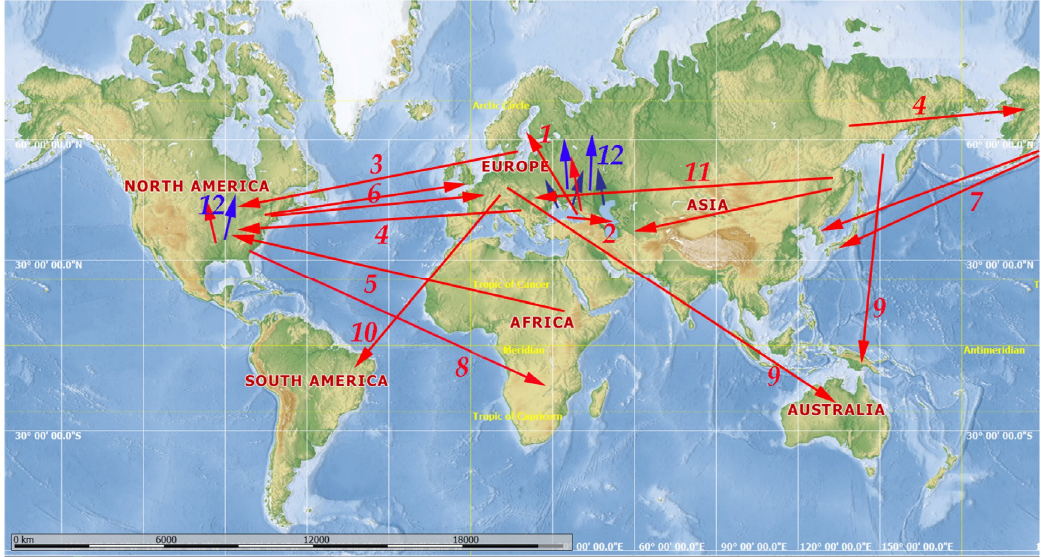
Figure 1. Main pathways of cladoceran long-distance transportation (red arrows) and range expansions (blue arrows) discussed in this study. The base map is from the public domain atlas in the desktop app, Marble 2.2.20 (https://marble.kde.org/index.php, accessed on 1 July 2022) [24]. Numbers correspond to the subsections in Section 3 (Results).